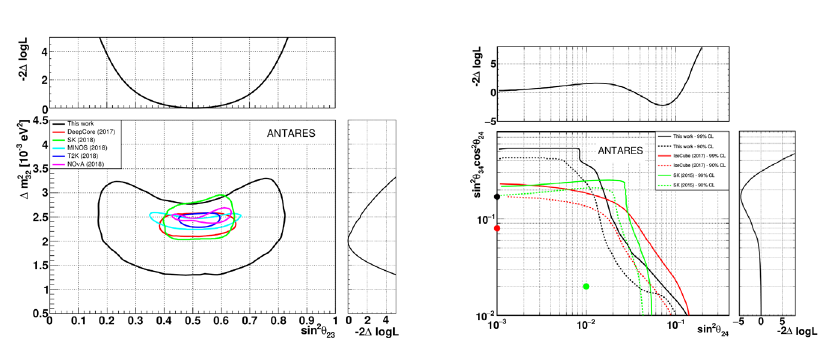
(black line) compared to 32 2 = sin 2 θ 2 = sin 2 θ 2 θ U µ 4 24 and | U τ 4 | 34 cos 24 obtained | |